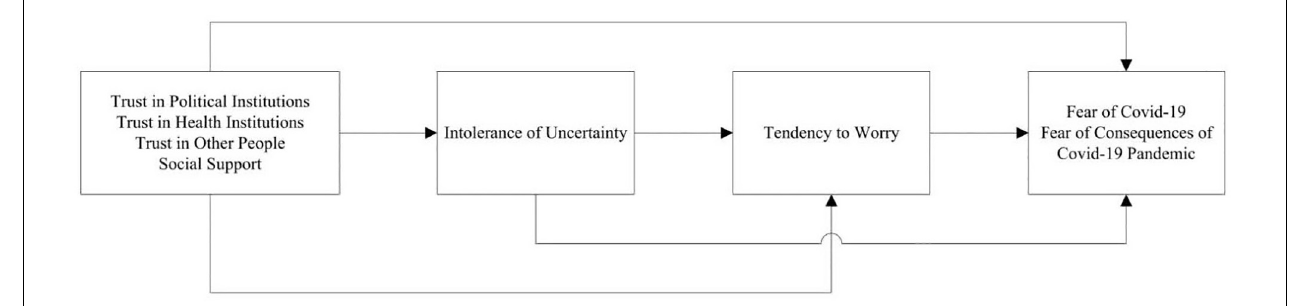
FIGURE 1 | Simplified representation of the initial model of associations between psychosocial and cognitive variables and COVID-19 related anxiety and worry.